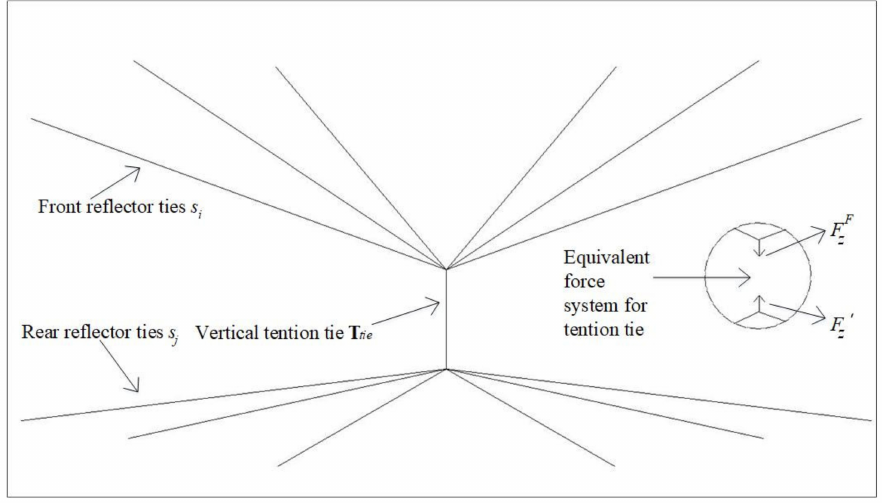
Figure 7. An element of a cable net